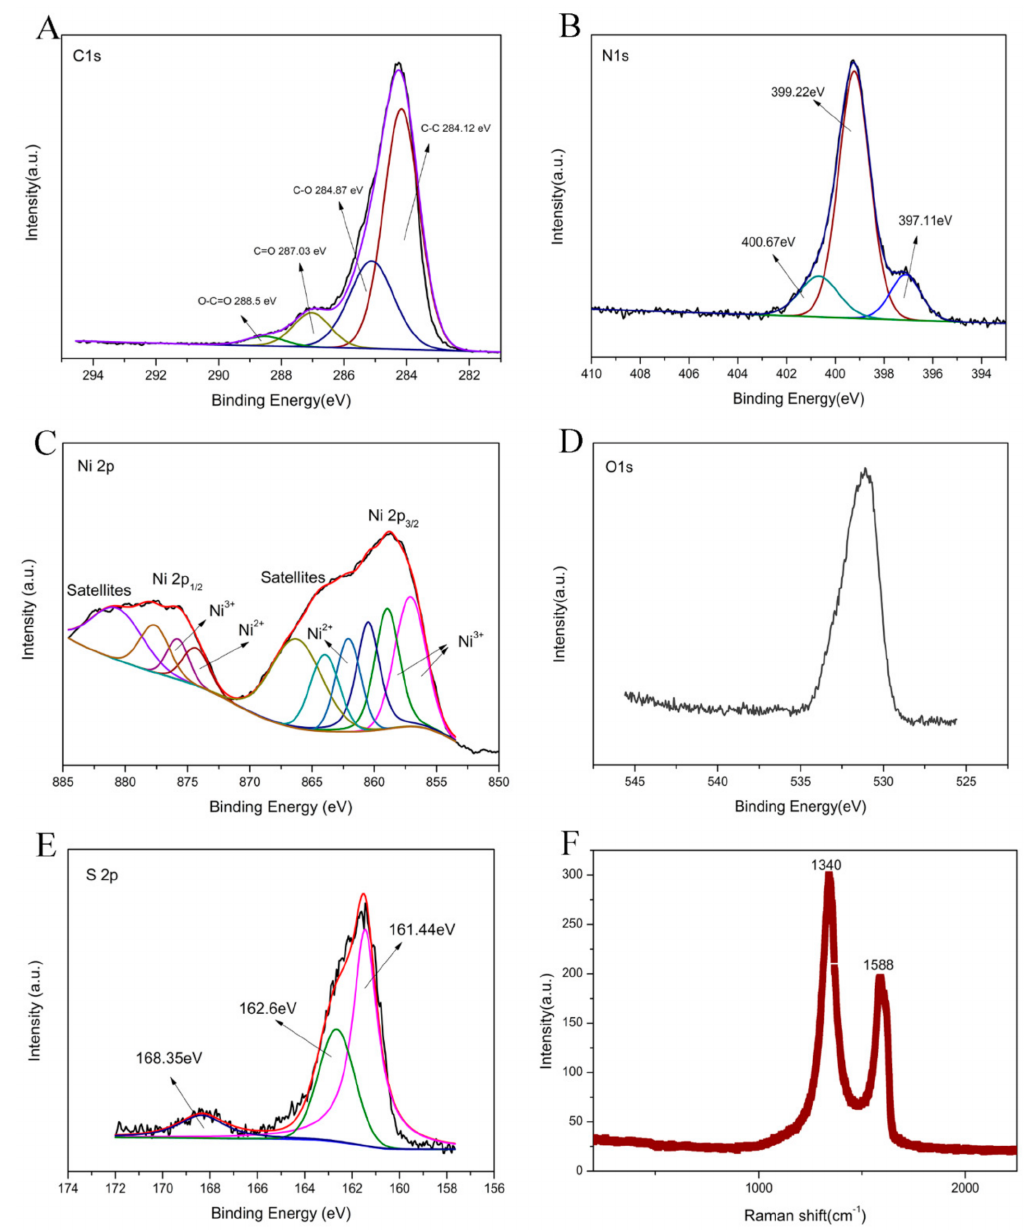
Figure 7. XPS spectrum of rGO-NS-Ni electrode: ( A ) C 1 s spectrum; ( B ) N 1 s spectrum; ( C ) rGO-NS-Ni 2 p spectrum; ( D ) O 1 s spectrum; ( E ) S 2 p spectrum; ( F ) Raman spectrum of